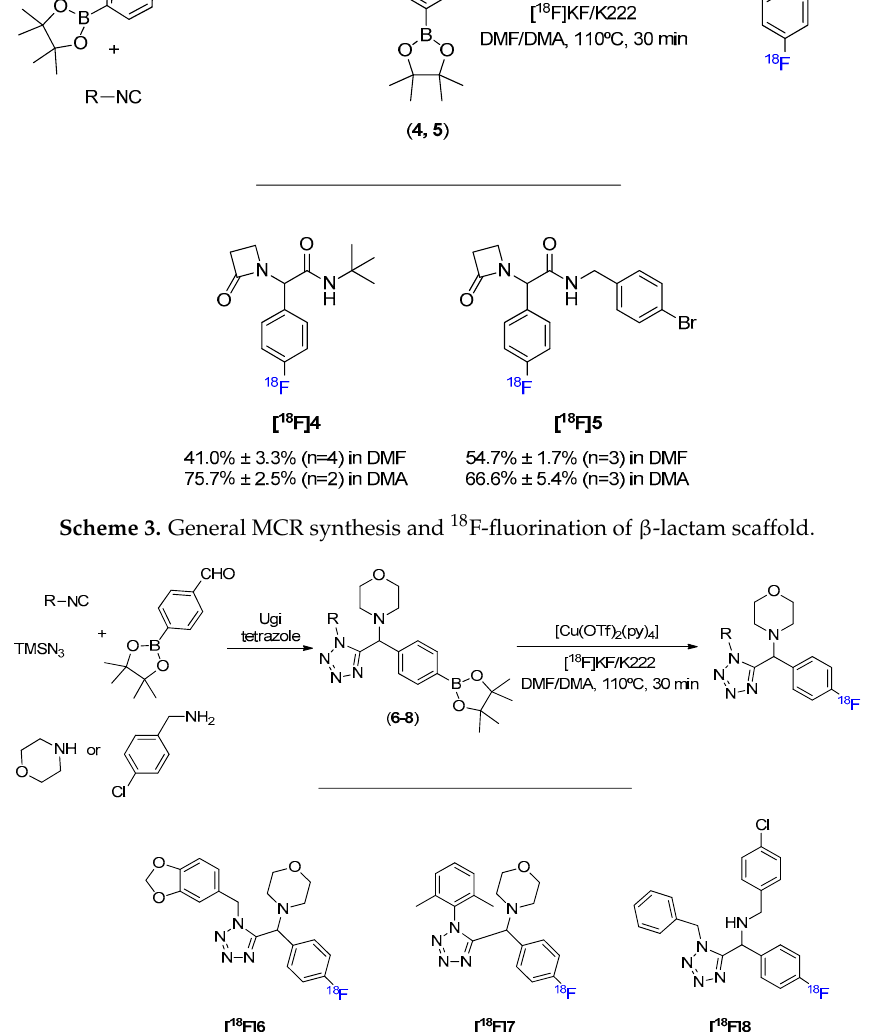
Scheme 3. General MCR synthesis and 18 F-fluorination of β -lactam scaffold.